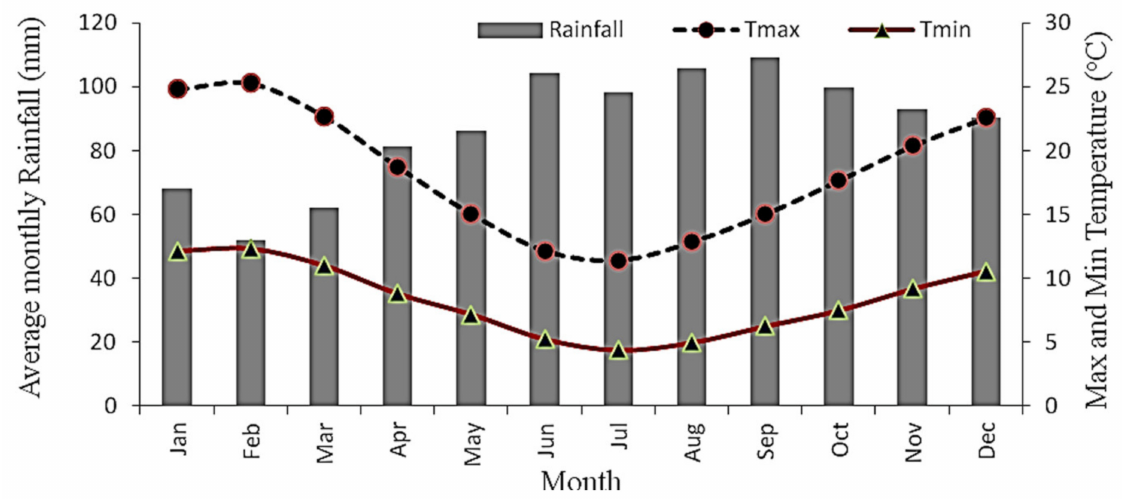
Figure 3. Average monthly rainfall and temperature (max and min) in the MYD [30].